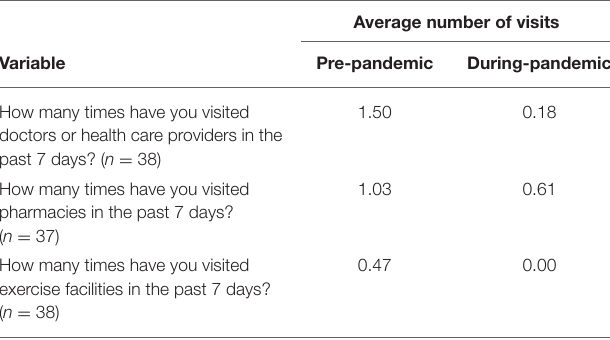
TABLE 3 | Self-reported frequency of visits to health-related facilities before and during the coronavirus